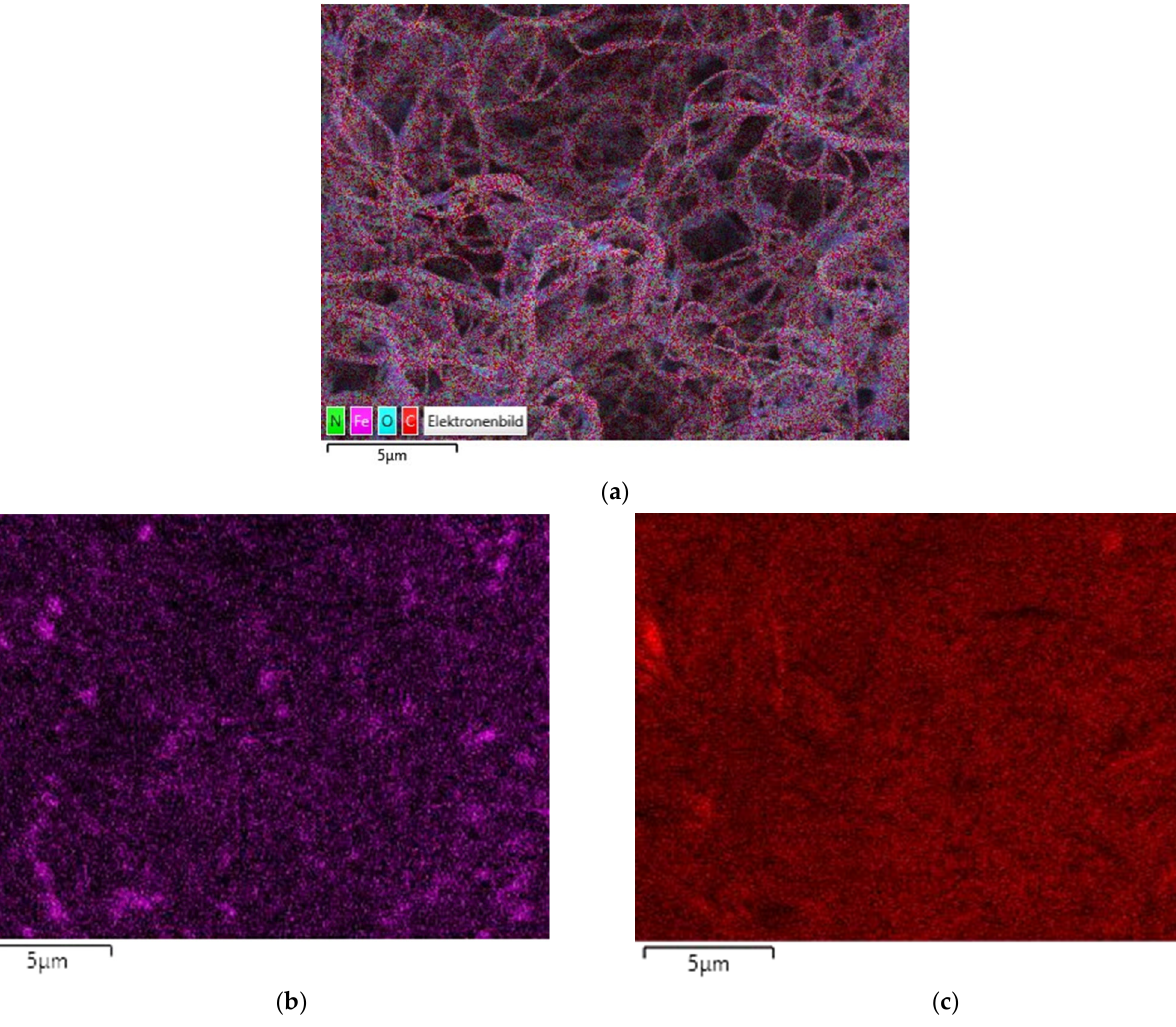
Figure 9. Energy dispersive X ‐ ray spectroscopy (EDX) maps of the particles distribution of 16 wt% PAN magnetic nanofiber mats; ( a ) EDX map of Fe = iron, C = carbon, N = nitrogen, O = oxygen elements; ( b ) EDX map of Fe = iron; ( c ) EDX map of C = carbon.